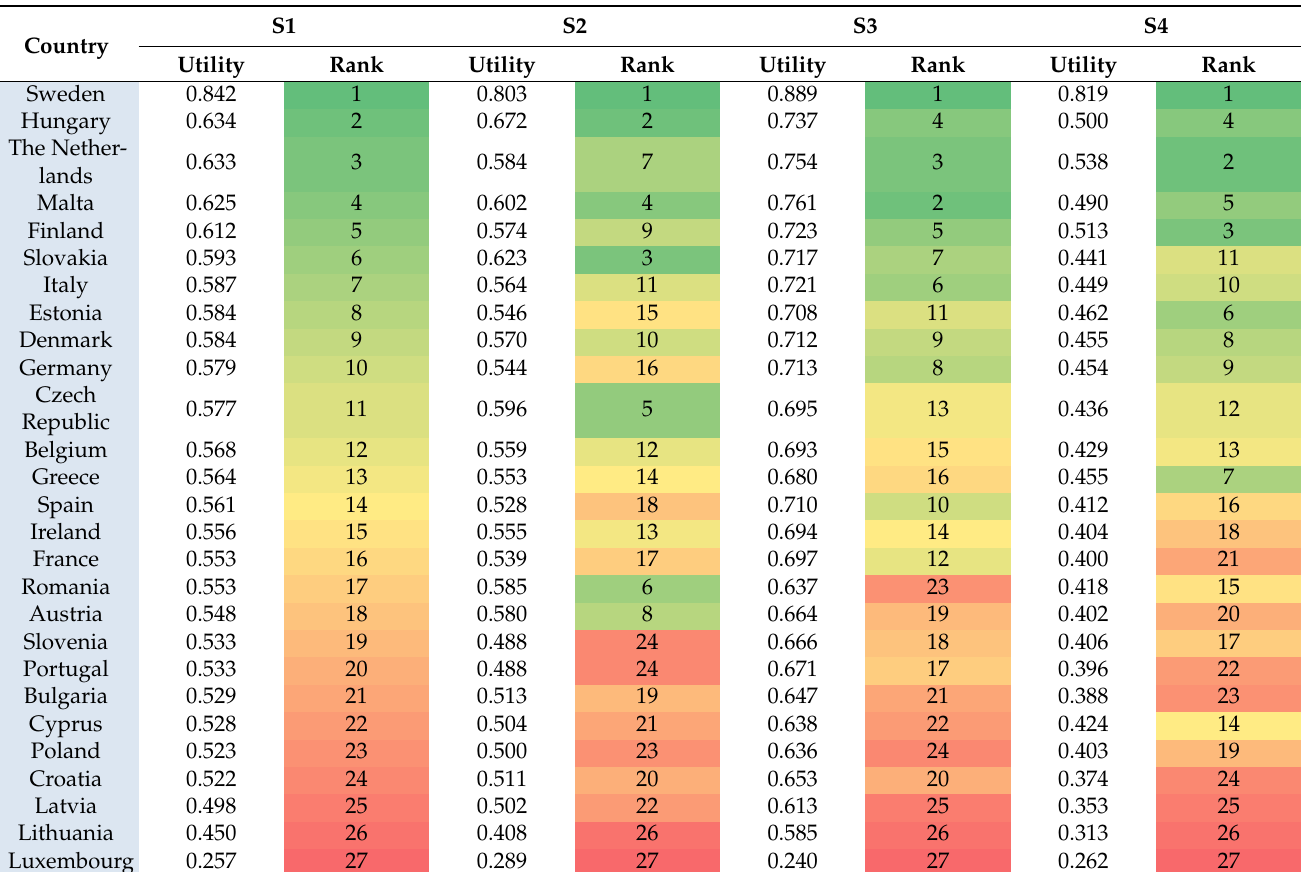
Table A4. Results and comparison of different weighting scenarios,